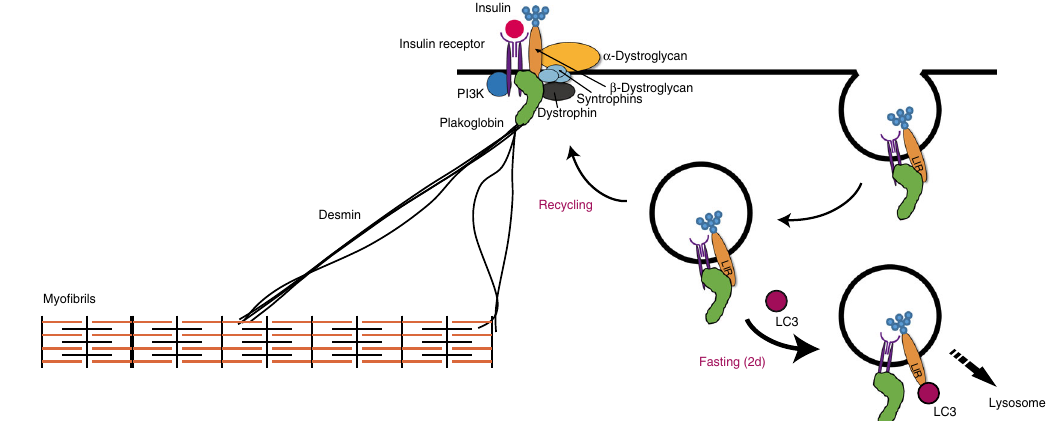
Fig. 6 Plakoglobin-DGC-insulin receptor association is regulated by autophagy. Muscles from fed and fasted (2 days) mice are analyzed. In fasting, contralateral limbs were transfected. Data are mean±SEM. P values by one-tailed t test. Fluorescence intensity was obtained using the Imaris software. a Top: Muscle cross-sections stained with indicated antibodies. Bar, 20 μ m. n = four independent experiments. Bottom: Fluorescence intensity. n = 4. * P <0.05 vs. fed. b Equal membrane extracts from muscles were analyzed by immunoblotting. n = two independent experiments. c Left: Plakoglobin immunoprecipitation from muscle membranes from mice treated with colchicine or vehicle was analyzed by immunoblotting. n = two independent experiments. Right: Densitometric measurement of presented blots. d Left: Muscle cross-sections from fasted mice treated with colchicine or vehicle were stained with indicated antibodies. Bar, 20 μ m. n = three independent experiments. Right: Fluorescence intensity. n = 3. * P <0.05 vs. vehicle injection. e Membranes puri fi ed from muscles expressing shLacz or 6His-plakoglobin were analyzed by glycerol gradients and immunoblot. Red rectangle marks fractions containing glycosylated- β - dystroglycan in shLacz-expressing muscles. n = four independent experiments. f Illustration of two potential LIR motifs in β -dystroglycan using iLIR database. g Left: In vitro competition assay: plakoglobin immunoprecipitation from membrane extracts from muscles of fed mice, followed by incubation in vitro with synthetic peptides corresponding to β -dystroglycan ’ s-LIR domains or scrambled control. β -Dystroglycan LIR-2 peptide ef fi ciently competed with β -dystroglycan on binding to plakoglobin. Right: Densitometric measurement, β -dystroglycan to plakoglobin ratio in protein precipitates following incubation with synthetic peptides. n = four independent experiments. * P <0.05 vs. scrambled. h Left: Cross-sections of muscles expressing GFP- β -dystroglycan or GFP- β -dystroglycan- Δ LIR from fasted mice were stained with indicated antibodies. Bar, 20 μ m. n = three independent experiments. Right: Fluorescence intensity of areas of potential colocalization on the plasma membrane. n = 3. * P <0.05 vs. GFP- β -dystroglycan. Bottom: Colocalization of indicated proteins in region of interest (region of co-occurrence, data are ratio to GFP- β -dystroglycan), and the corresponding Pearson ’ s correlation coef fi cients of colocalization. n = 7, two independent experiments. * P <0.05 and ** P <0.005 vs. GFP- β -dystroglycan. i Proposed model: Under normal conditions, basal recycling of plakoglobin-DGC- insulin receptor co-assemblies occurs via plakoglobin masking β -dystroglycan LIR domains. During fasting, when autophagy is induced, LC3 competes with plakoglobin on binding to β -dystroglycan ’ s LIR domains, directing the formed vesicles to the